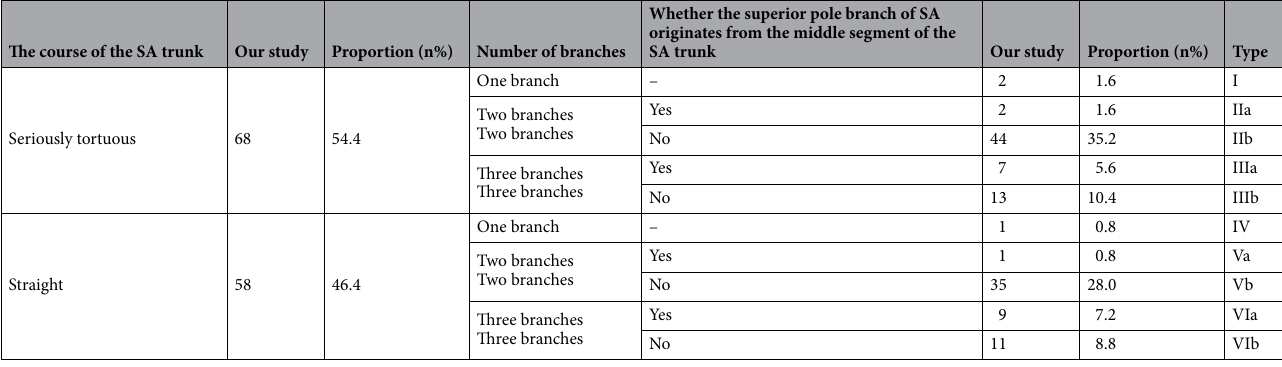
Table 7. Splenic artery